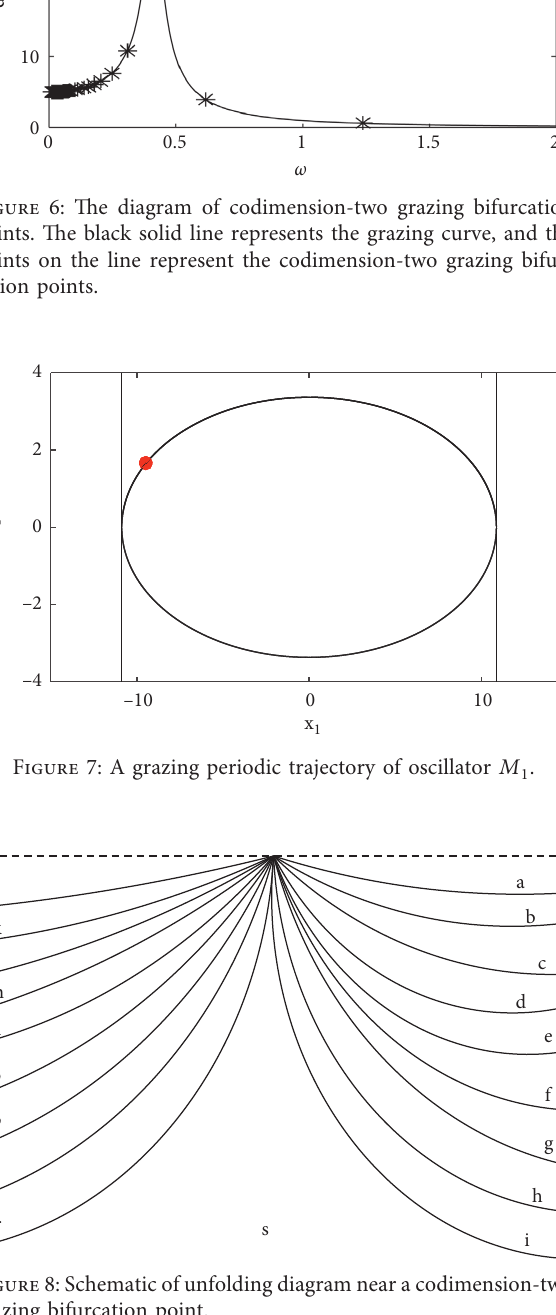
Figure 8: Schematic of unfolding diagram near a codimension-two grazing bifurcation